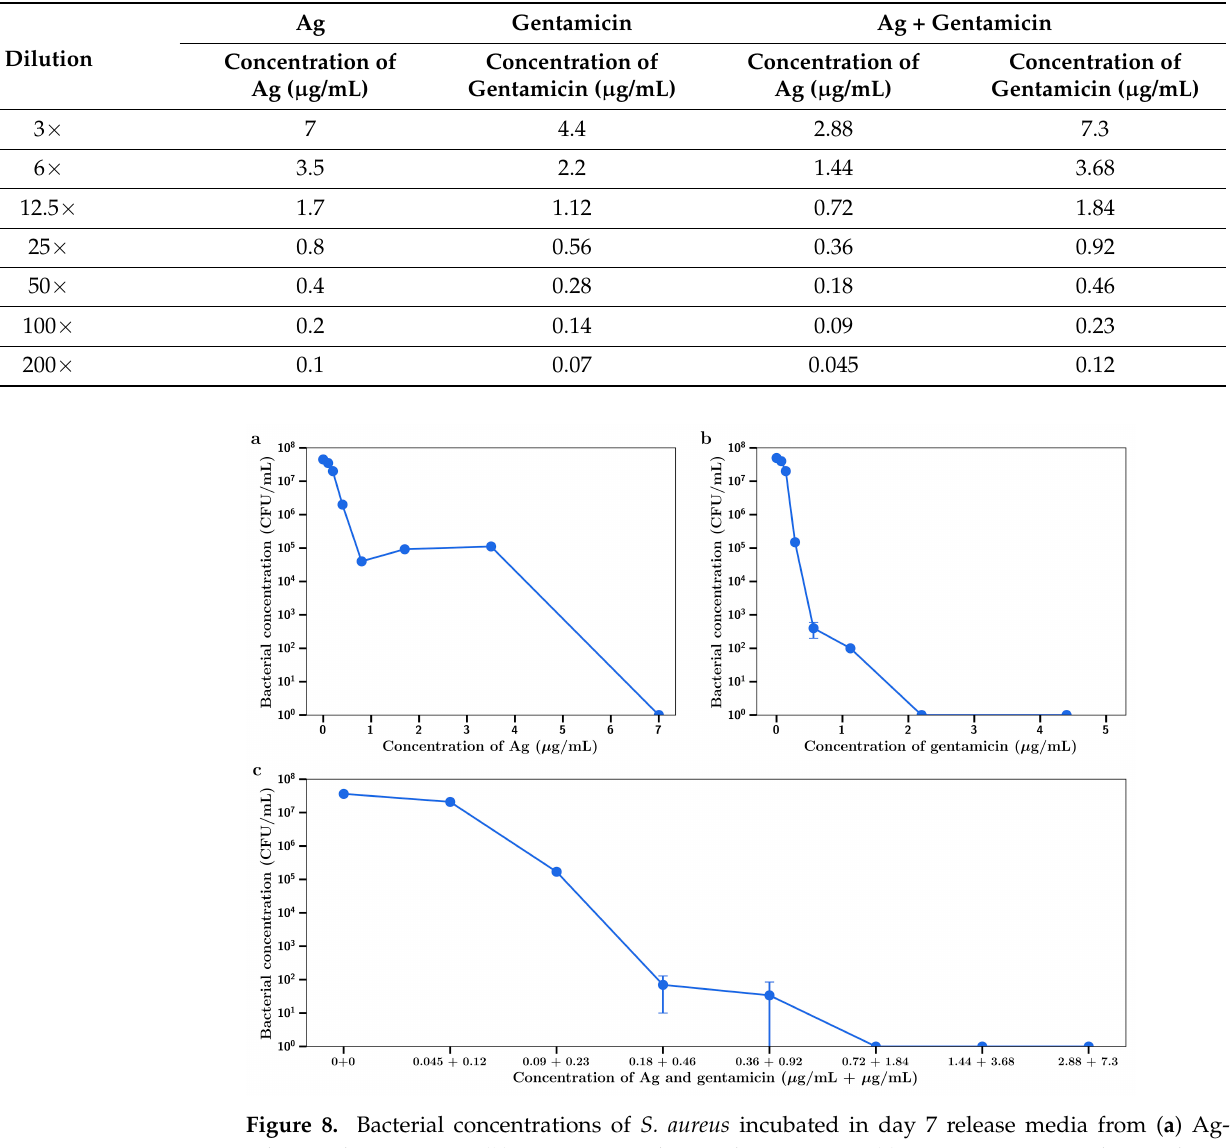
Table 2. Concentration of drugs in day 7 diluted release media from bone cement loaded with silver nitrate, gentamicin or both.